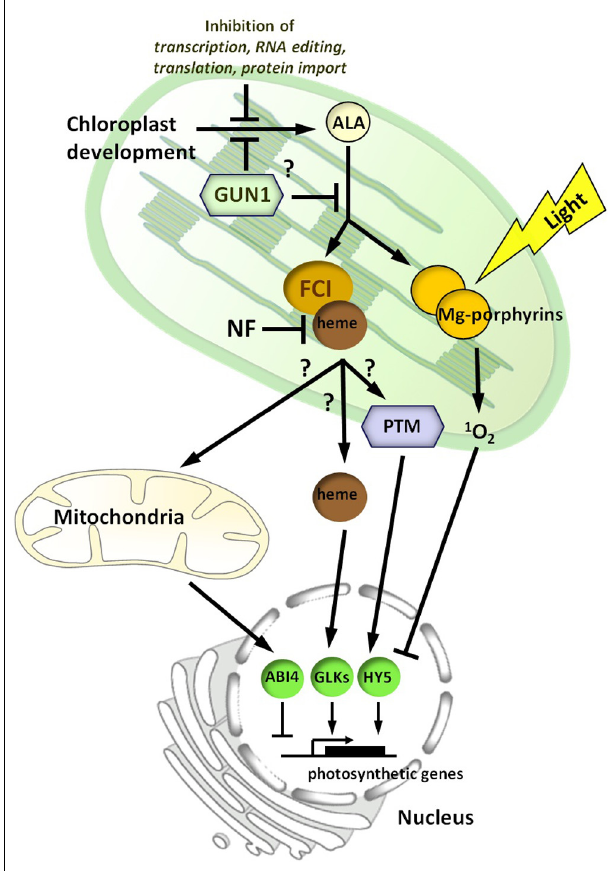
FIGURE 3 |A model for chloroplast to nucleus signaling during chloroplast biogenesis. In this model, there are two signaling pathways proposed. A positive heme-related signal, mediated by ferrochelatase 1 (FC1), whose production reflects the developmental status of the chloroplast. Inhibition of chloroplast development by norflurazon (NF) treatment blocks production or transmission of this signal.The heme-related signal may be heme itself or a heme metabolite, and is possibly conveyed via the mitochondria.The plant homeodomain transcription factor (PTM) is also a good signaling candidate and a number of other nuclear-localized transcription factors, including ABI4, HY5, and GLK1/2 have been implicated. GUN1 is proposed to repress chloroplast development or the synthesis of the signal before or after the synthesis of the rate-limiting intermediate 5-aminolevulinic acid (ALA).The environment can impact adversely on the positive signal through effects on chloroplast development. Under conditions in which this leads to excess accumulation of chlorophyll precursors, such as Mg-porphyrins, a second inhibitory light-dependent signal, mediated by singlet oxygen ( 1 O 2 ), represses photosynthetic and tetrapyrrole synthesis